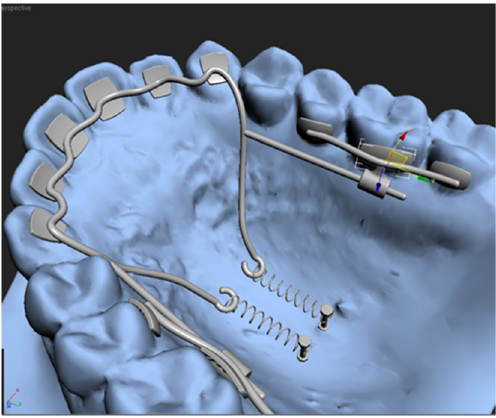
Figure 12. Virtual design of antero-posterior lingual retractor with software program.